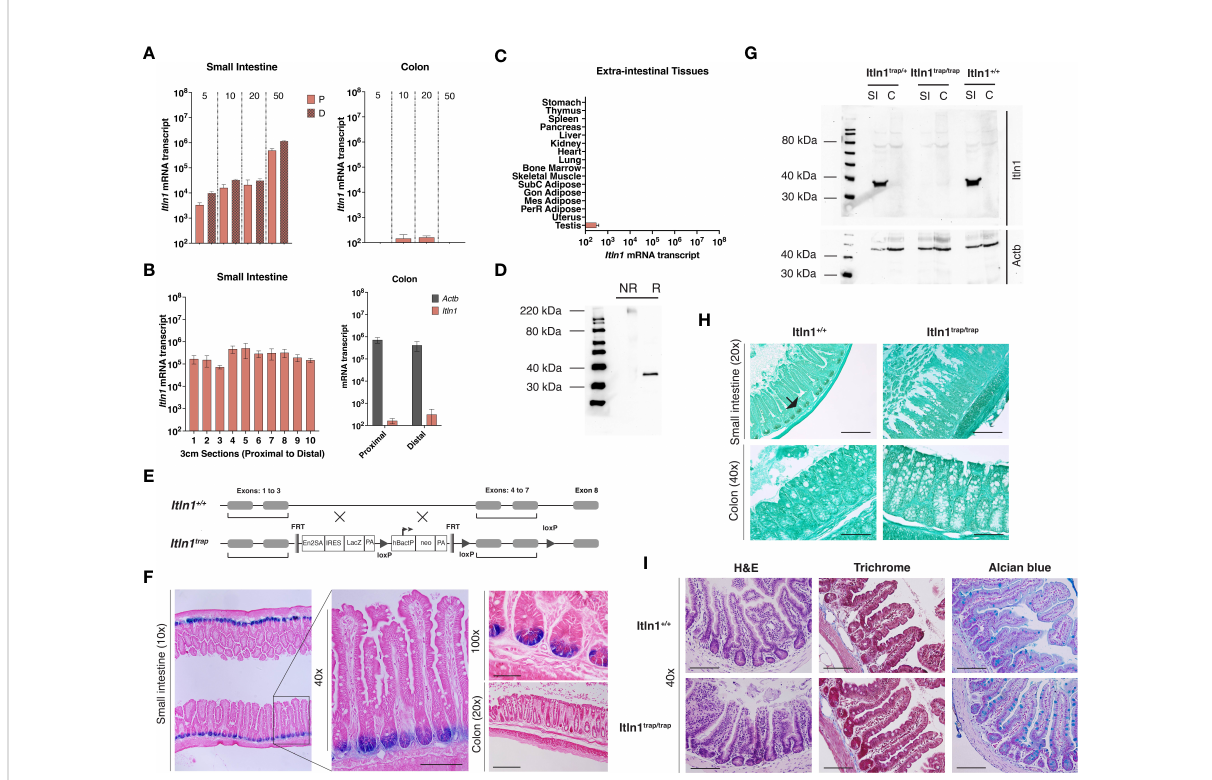
FIGURE 1 Characterization of intelectin-1 ( Itln1 ) and an Itln1 knockout model in C57BL/6N mice. (A) Quantitative RT-PCR analysis of Itln1 mRNA in the proximal 10 cm ( “ P ” ) and distal 10 cm sections ( “ D ” ) of the small intestine (left) and whole colon (right) at post-natal day 5, 10, 20 and 50. (B) Itln1 mRNA expression in 3 cm sections of small intestine arranged proximal (#1) to distal (#10) and colon divided into two equal length sections in adult mice. (C) Extra-intestinal tissue expression levels of Itln1 mRNA. (A-C) Error bars represent standard error of the mean, n = 4 mice. (D) Immunoblot of Itln1 from small intestinal lysate: NR, non-reduced, denatured; R, reduced, denatured. (E) Schematic of Itln1 trap cassette. (F) b - galactosidase staining in the small intestine of Itln1 ( Itln1 trap/trap ) mice. The TM1A trapping cassette contains an internal ribosome entry site upstream of the reporter LacZ, which allows expression of b -galactosidase under control of the Itln1 promoter. X-gal staining was detected in Paneth cells in the small intestinal crypts. b -galactosidase staining is absent in the colon of Itln1 trap/trap mice. (G) A representative immunoblot of Itln1 in small intestine (SI) and colon (C) from Itln1 +/+ , Itln1 trap/+ , and Itln1 trap/trap mice. (H) Immunohistochemistry of Itln1 in Carnoy ’ s fi xed small intestine and colon of Itln1 +/+ and Itln1 trap/trap mice. Black arrows indicate small intestinal crypts. (I) Representative images of distal small intestine of Itln1 +/+ and Itln1 trap/trap mice indicating absence of baseline in fl ammation (no cellular in fi ltrate or fi brosis; H&E and Masson ’ s trichrome) and similar appearance of crypts, villi, and cellular numbers (e.g., goblet cells; alcian blue) between genotypes. Scale bars: 20x = 200 µm, 40x = 100 µm, 100x = 50